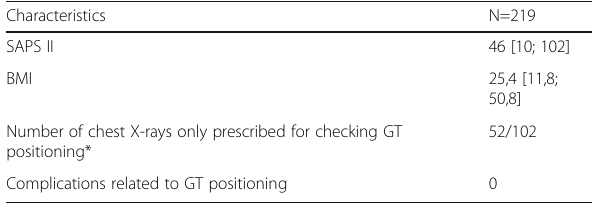
Table 1 (abstract 000507). Patients characteristics